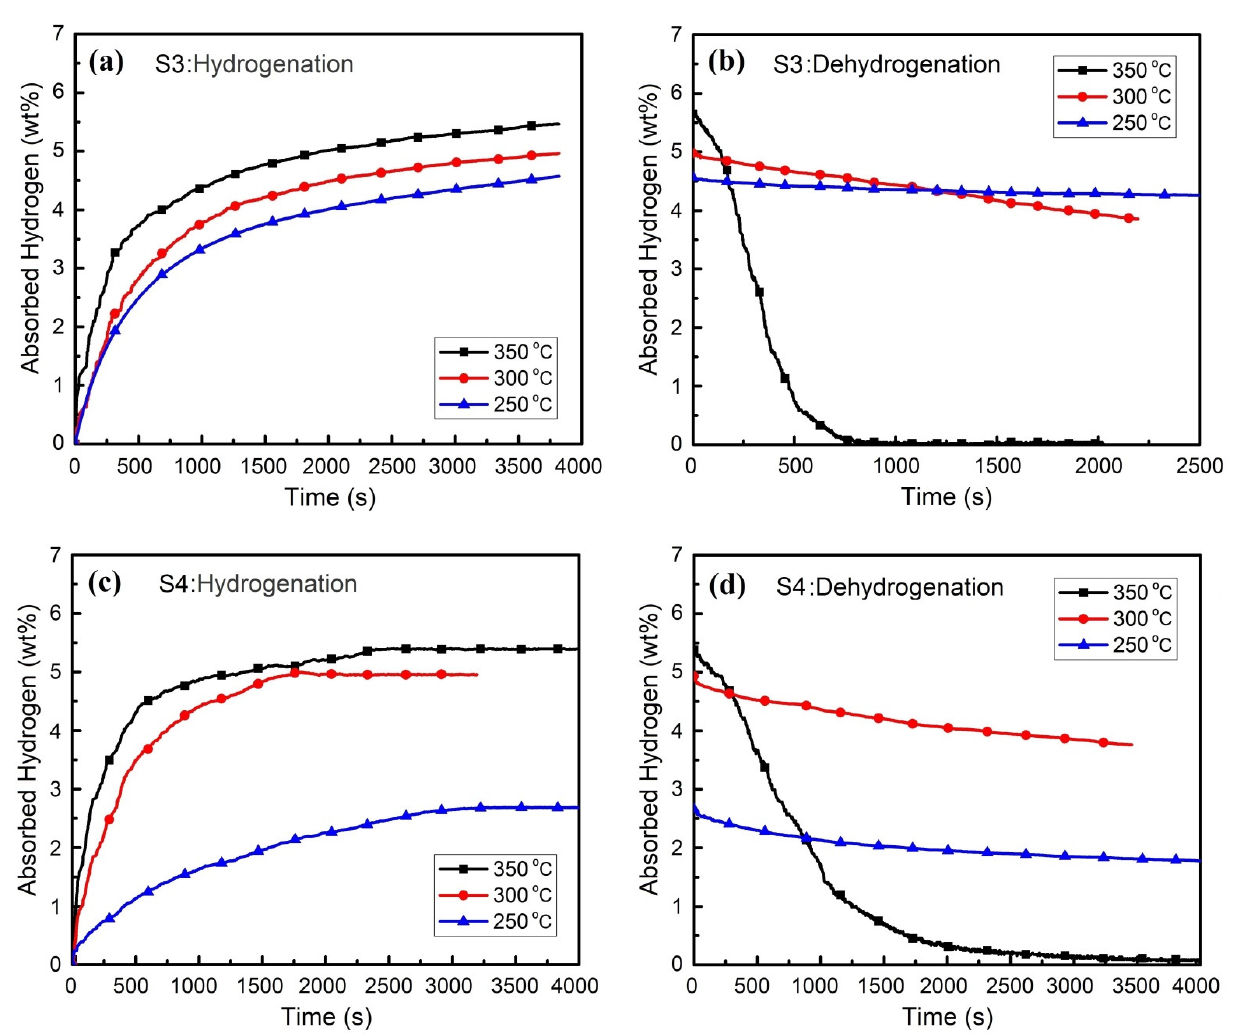
Figure 3. Hydrogenation kinetics at 30 bar and dehydrogenation kinetics at 10 -1 mbar for different temperatures: ( a , b ) S3 sample (second pass of TPCAE at 250 °C); ( c , d ) S4 sample (second pass of TPCAE at 200 °C).